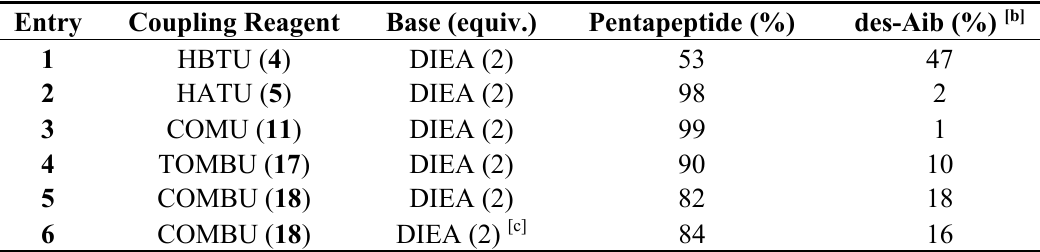
Table 5. Percentage purity of pentapeptide 26 (H-Tyr-Aib-Aib-Phe-Leu-NH 2 ) during solid-phase assembling, in the presence of the side product forming tetrapeptide